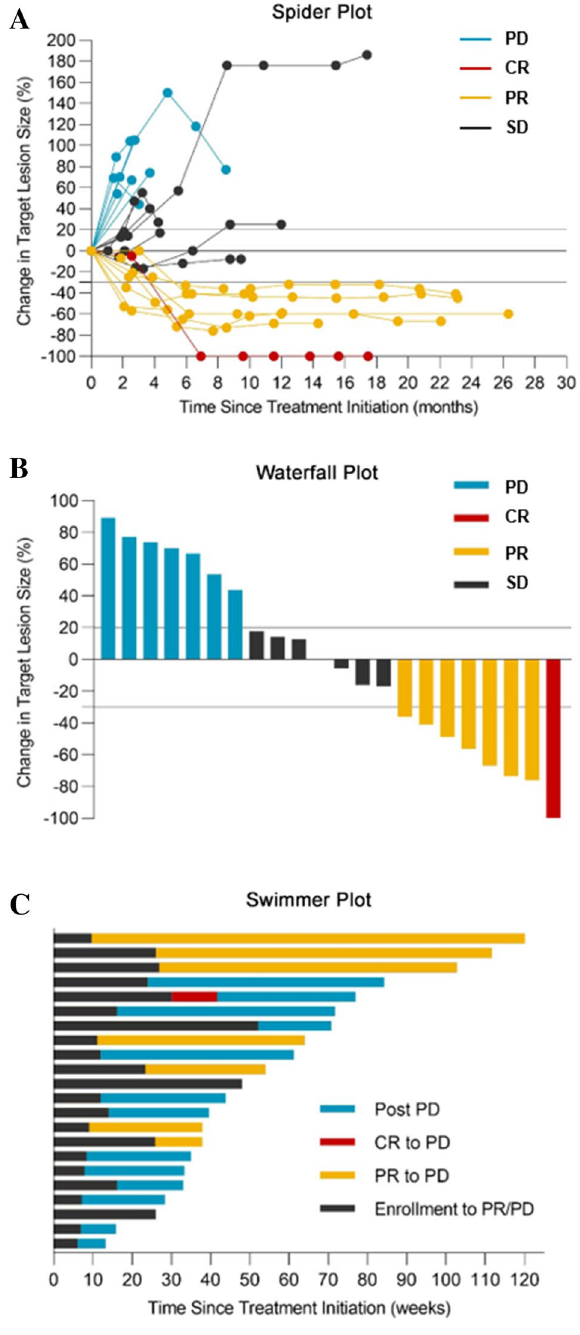
Figure 2. Responses of patients with platinum-sensitive R/M-HNSCC to nivolumab based on the RECIST guidelines (version 1.1). ( A ) Change in the sum of target lesions over time from baseline to PD. The upper dashed line represents the threshold for PD, and the lower dashed line shows the threshold for PR. ( B ) Best reduction in the target lesions from baseline. The upper dashed line represents the threshold for PD (20% increase in the sum of the longest diameter of the target lesions). The lower dashed line shows the threshold for PR (30% decrease in the sum of the longest diameter of the target lesions). ( C ) Time to response and duration of survival. Each bar represents a single patient, with the length of the bar corresponding to overall